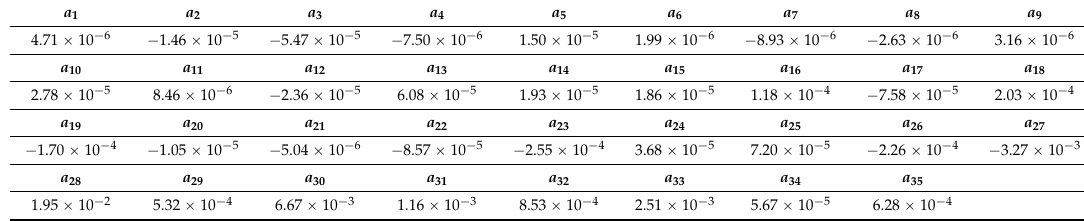
Table A1. Parameters of freeform surface 1.